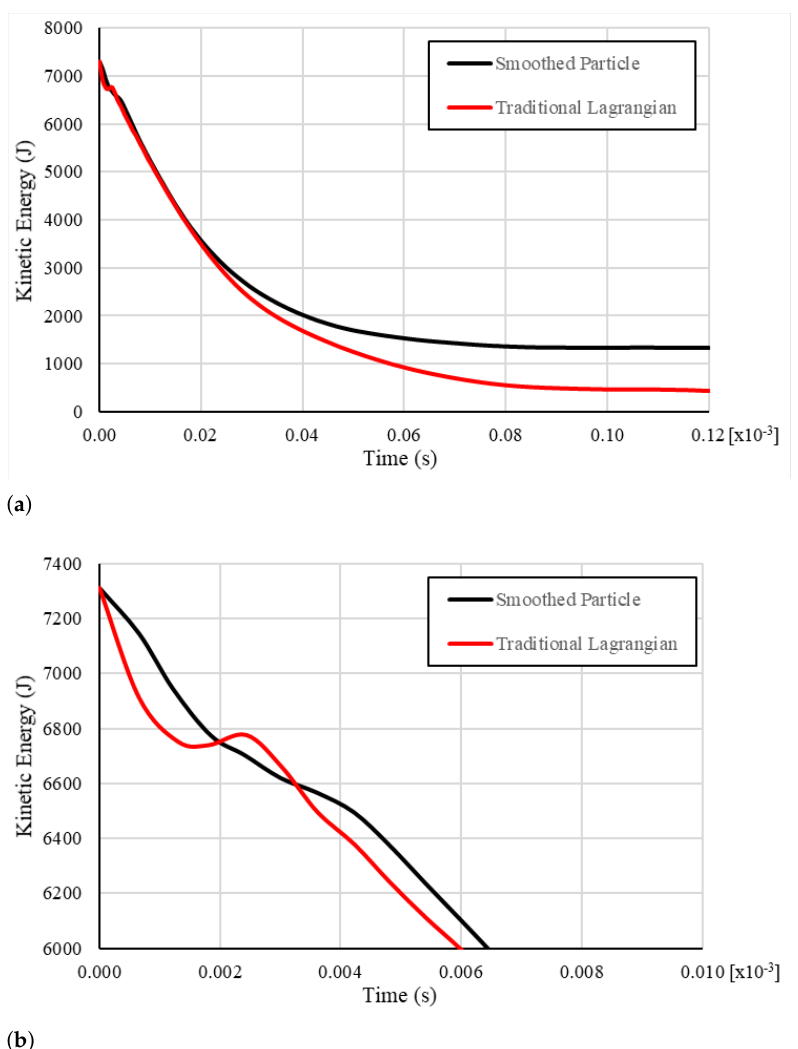
Figure 17. Model Kinetic Energy versus Time Comparison: ( a ) Full Run Duration, ( b ) Initial